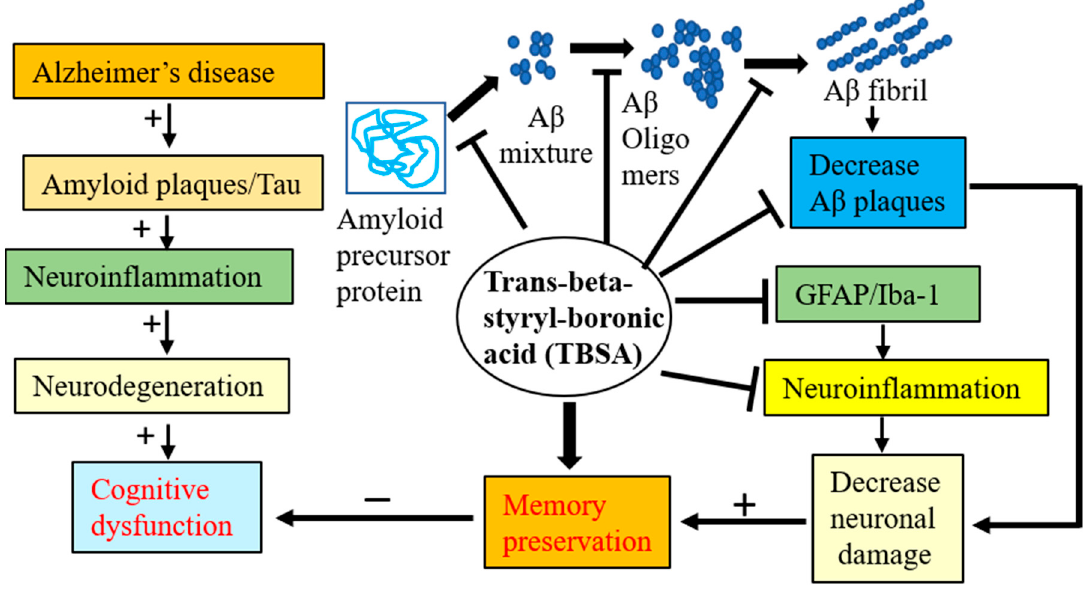
Figure 11. Possible mechanism of anti-amyloid and antineuroinflammatory action of TBSA in animal models of AD. Schematic diagram shows the anti-amyloid and antineuroinflammatory mechanism of trans-beta-styryl-boronic acid (TBSA) which prevented neuronal damage and preserved spatial memory in 5xFAD mice.